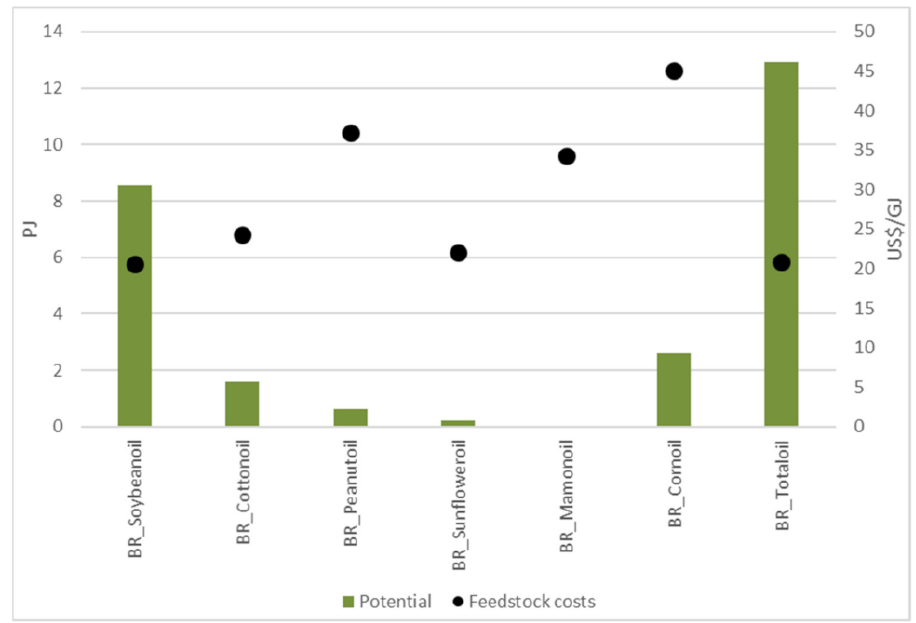
Figure 12. SVO potential and average cost in